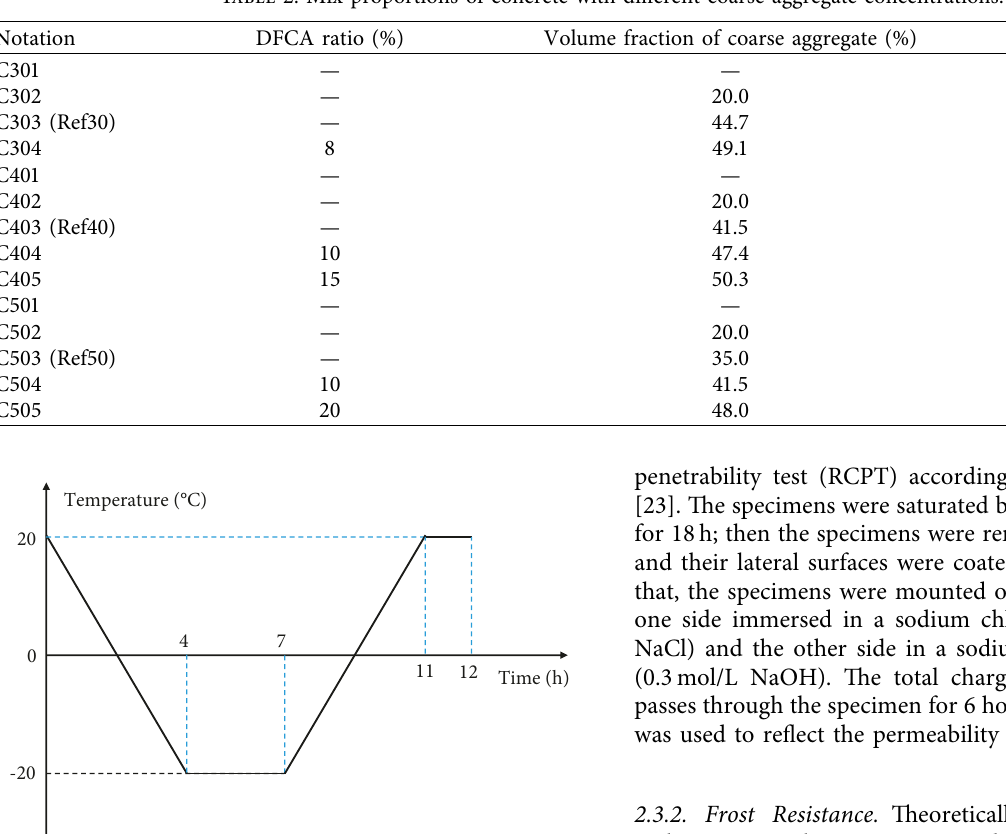
Table 2: Mix proportions of concrete with different coarse aggregate concentrations.